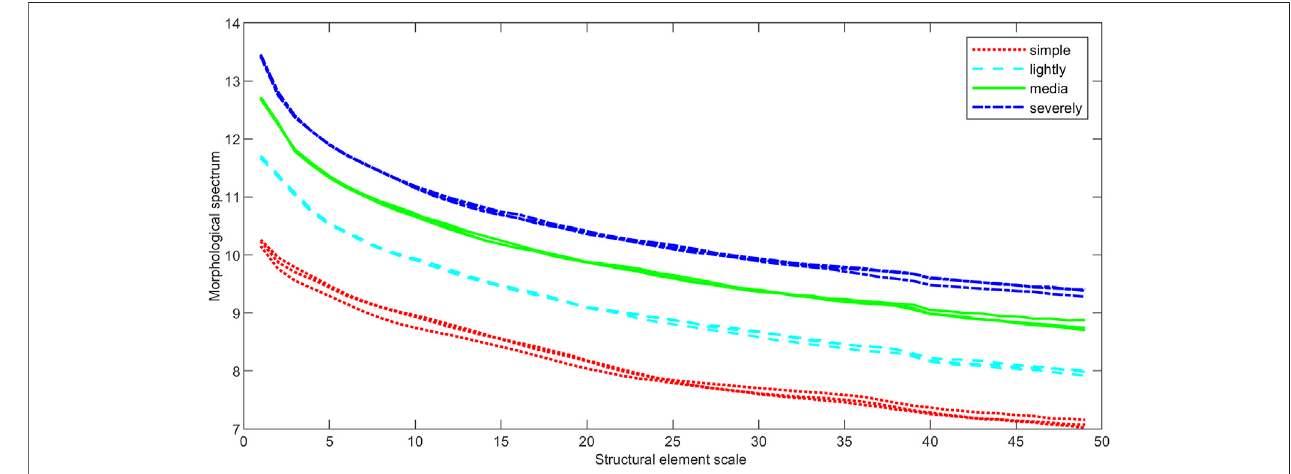
FIGURE 9 | LMGS analysis result of square SE.